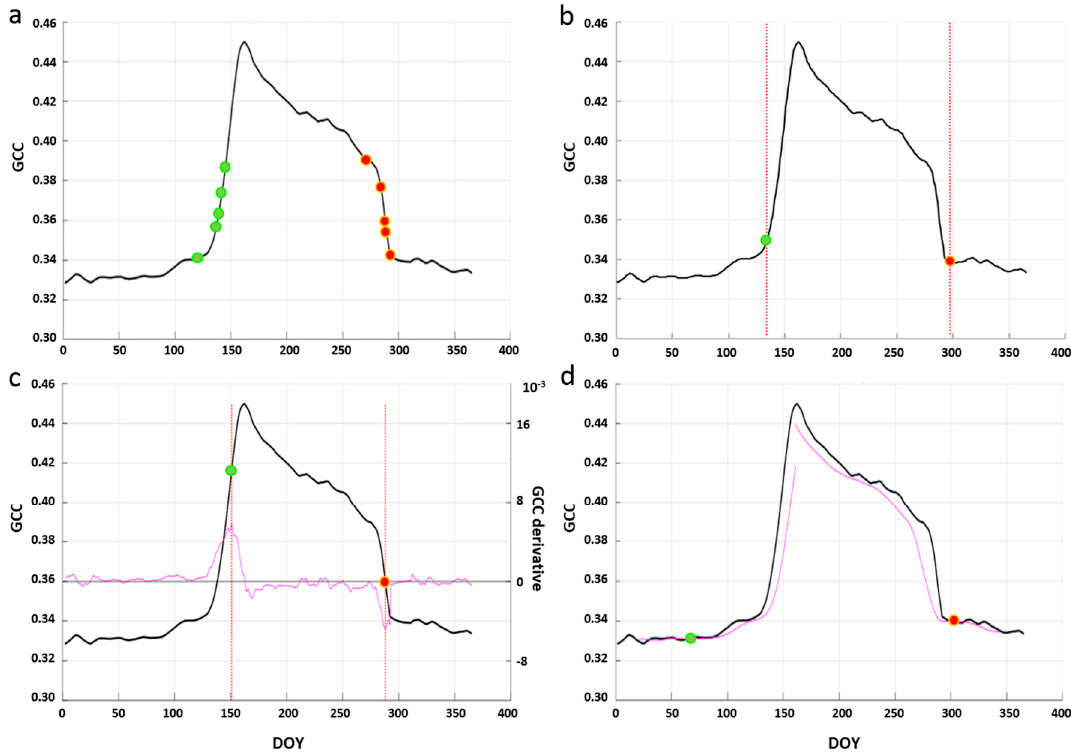
Figure 3. Illustration of the threshold ( a ), logistic-function ( b ), derivative ( c ) and moving-average ( d ) phenological extraction methods applied to PhenoCam G CC time series of Acadia site (44.37ºN, 68.26ºW) for 2014. The green and red points correspond to SoS and EoS, respectively. The different points in panel a correspond to the percentiles 10th, 25th, 30th, 40th and 50th. The purple line corresponds to the first derivative in c , and to the moving average in d .